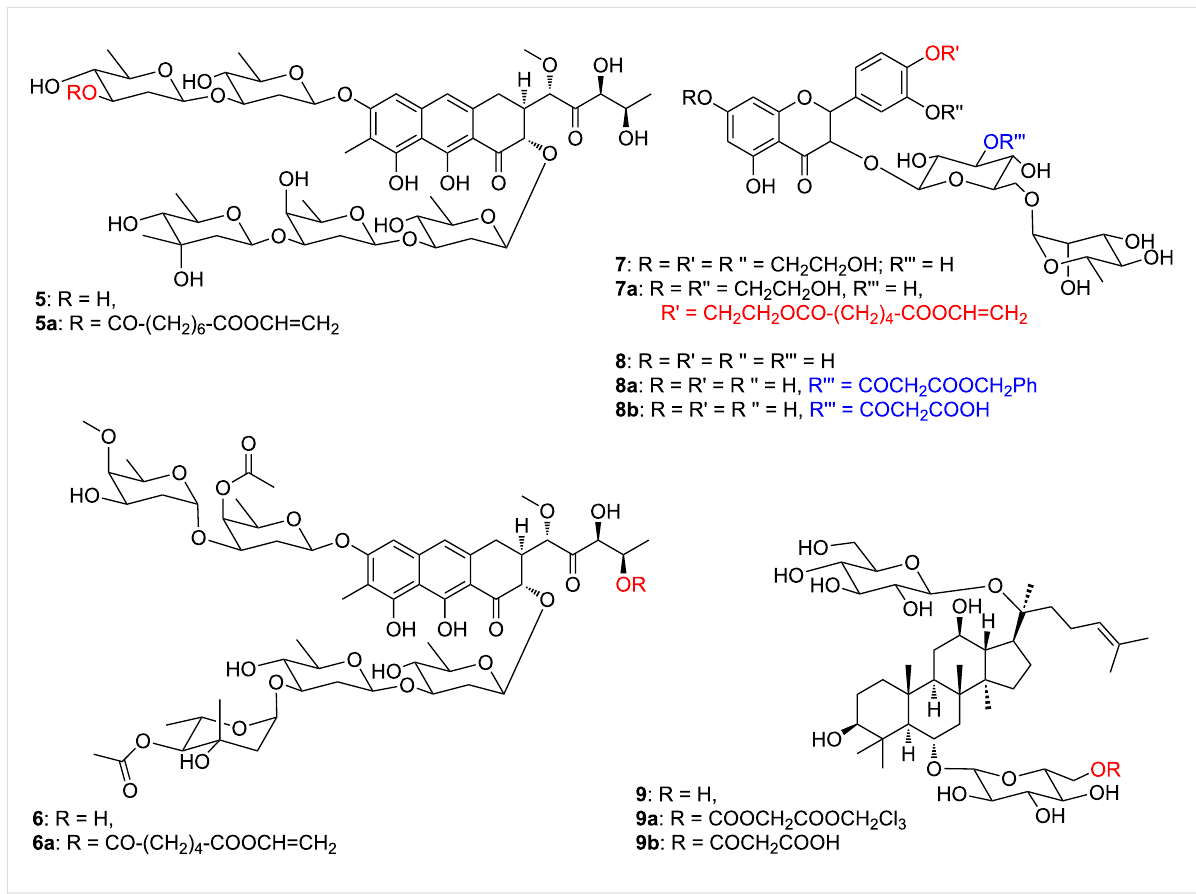
Figure 1: Example of natural compounds selectively acylated with dicarboxylic esters.